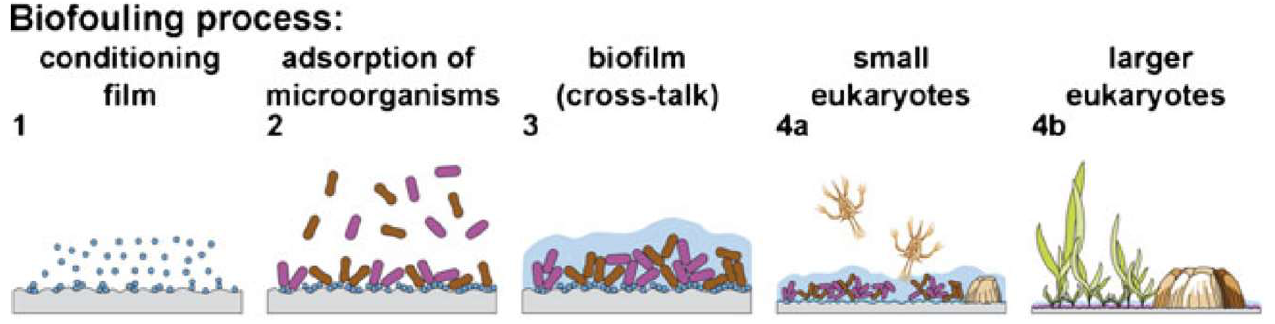
Figure 1. Stages of the typical fouling sequence that occurs on submerged surfaces. Re- printed/adapted with permission from Ref. [9]. 2013, Springer Nature.